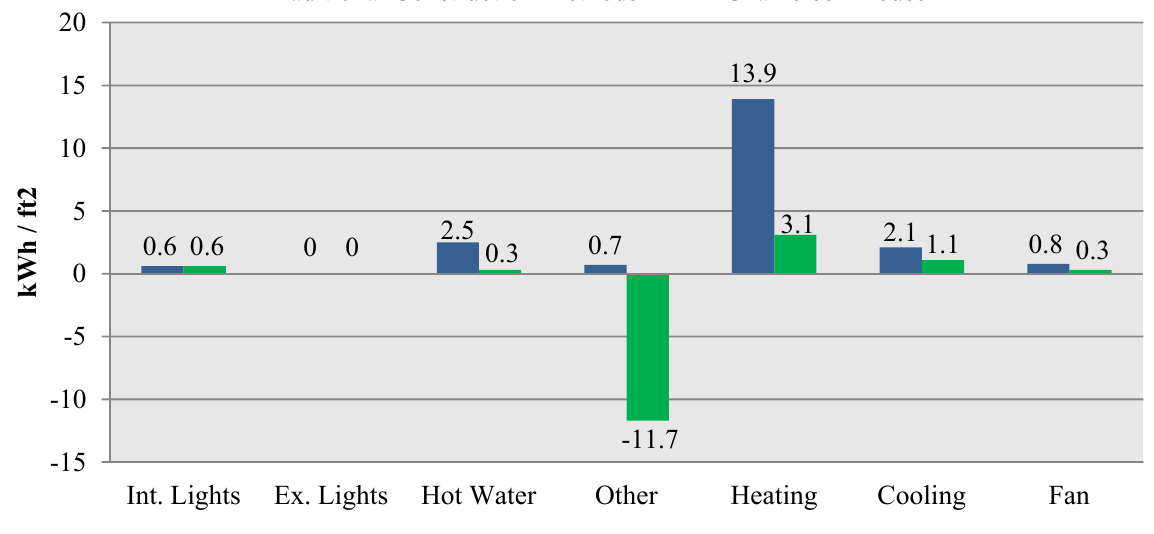
Figure 11. Monthly electric demand peaks—Including PV